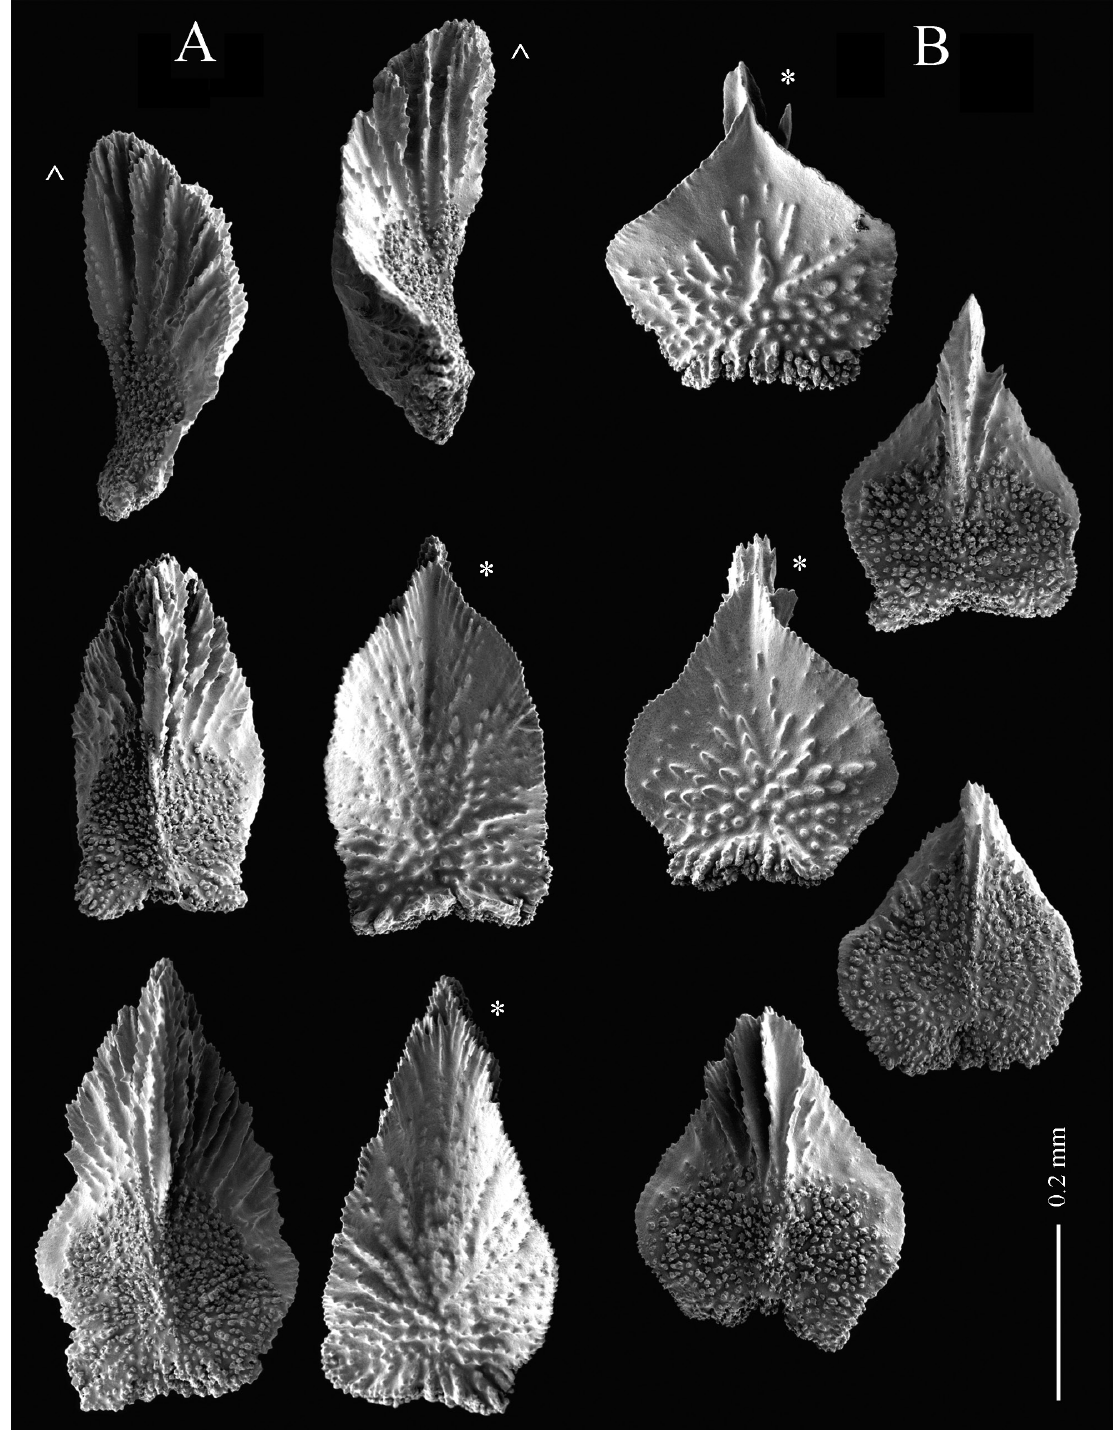
Fig . 5. – Thouarella regularis (Wright and Studer, 1889), lectotype (NHMUK 1889.5.27.60): A, opercular scales; B, marginal scales. [*outer surface view; ^ lateral